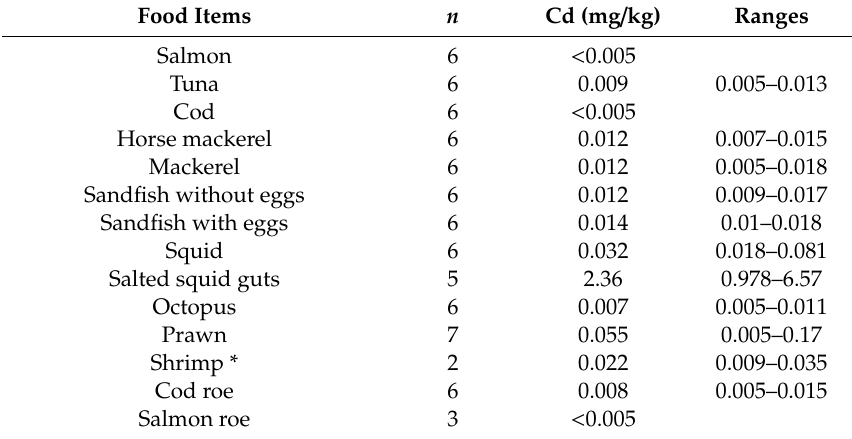
Table 7. Cadmium (Cd) concentrations in fish and shellfish. Data are presented as arithmetic